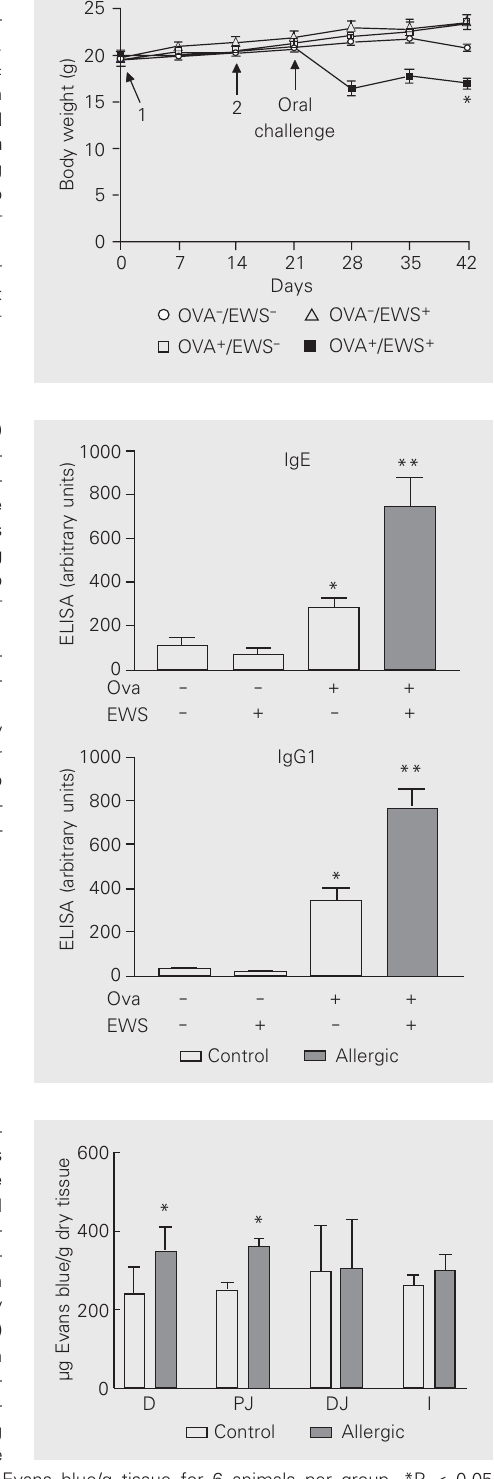
Figure 3. Intestinal vascular per- meability. Extravasation of Evans blue dye in the small